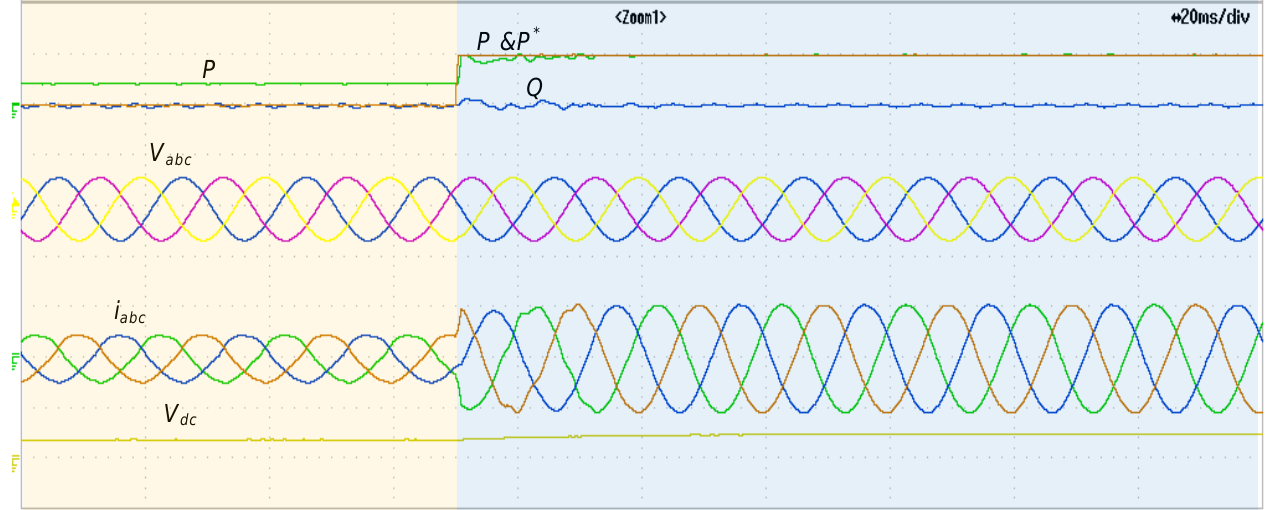
Figure 11. Real-time simulator results: active power reference step-up for BES-P2G. From top: active power reference ( P* , 10 kW/div), active power ( P , 10 kW/div), reactive power ( Q , 10 kVAR/div), grid voltage ( V abc , 1000 V/div), grid current ( i abc , 20 A/div), DC link voltage ( V dc , 1400 V/div).